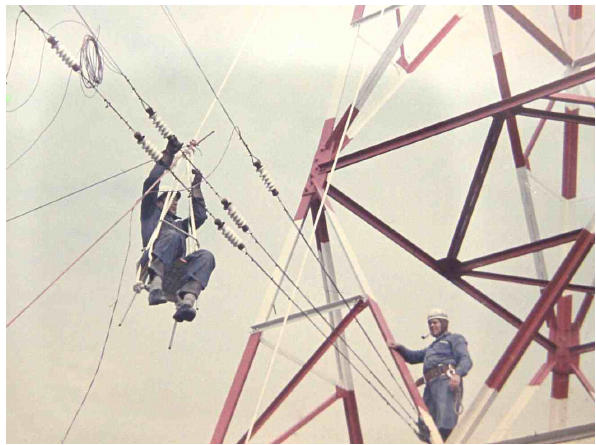
Figure 25. The “Feierabend-Brigade” of Juliusruh Station cele- brates the completion of a pathway trough the compound with a celebratory